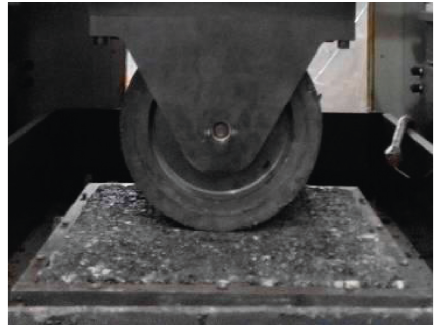
Figure 5: Rut test.